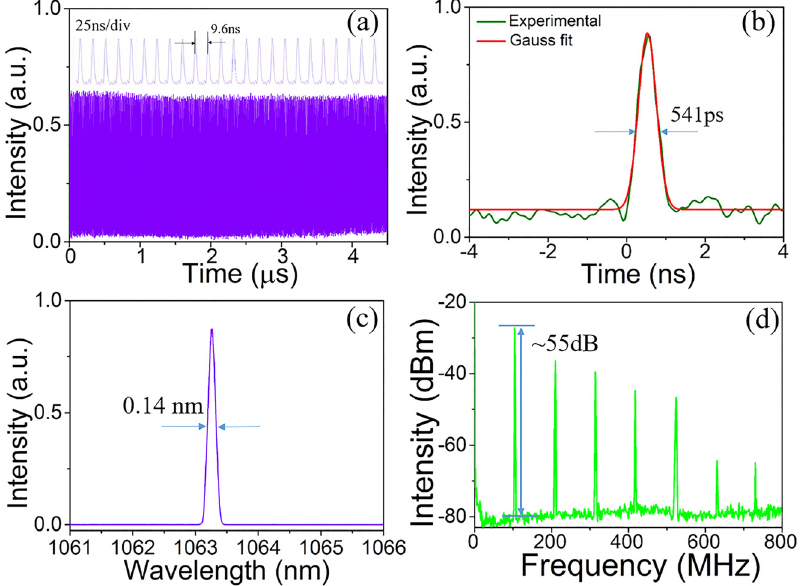
Figure 9: Experimental performances of the continuous wave mode-locking (CWML) lasers with TiO 2 /CuO nanocomposites at 1.06 μ